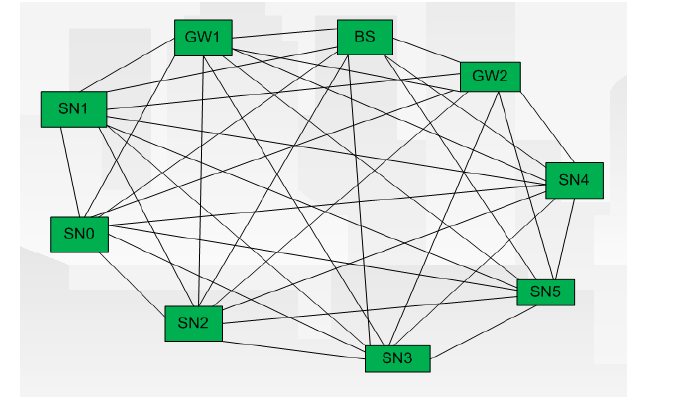
Figure 1. Dense topology sensor network scenario